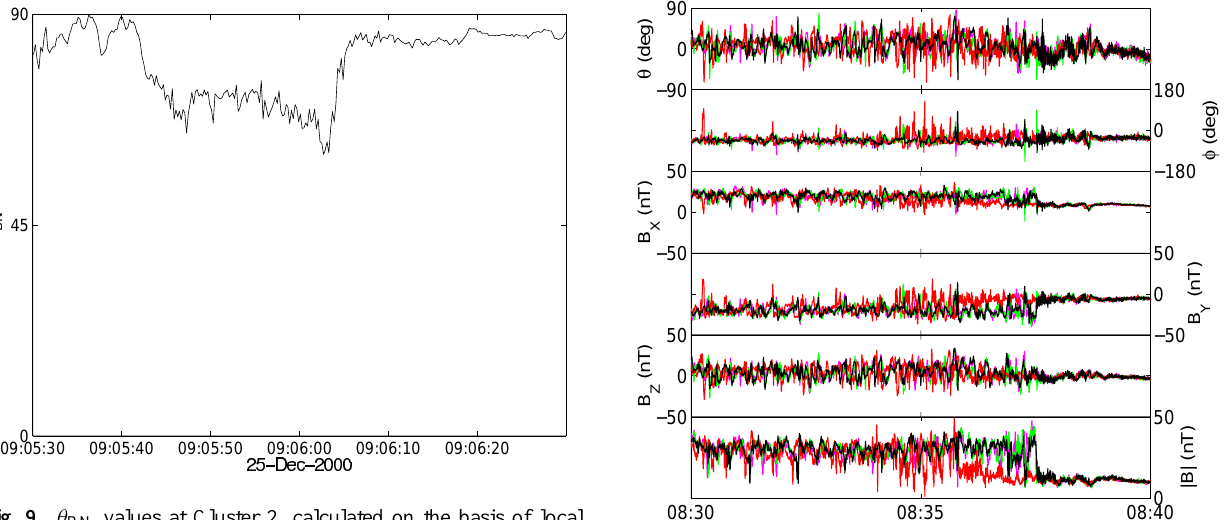
Fig. 9. θ BN values at Cluster 2, calculated on the basis of local magnetic field data and a normal similar to that at recent shocks, for the same time period as Fig. 8.